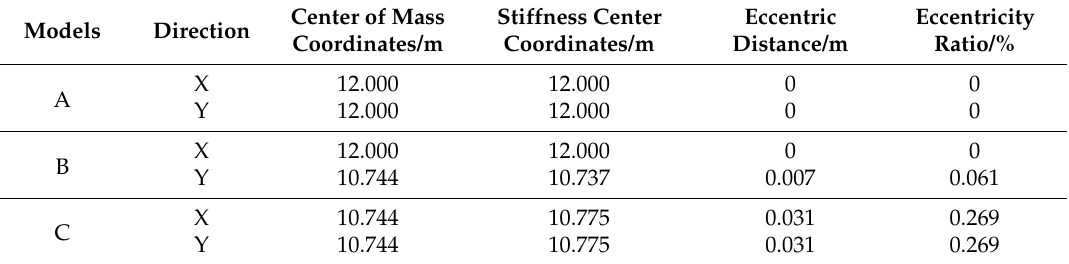
Table 2. Eccentricity of the isolation